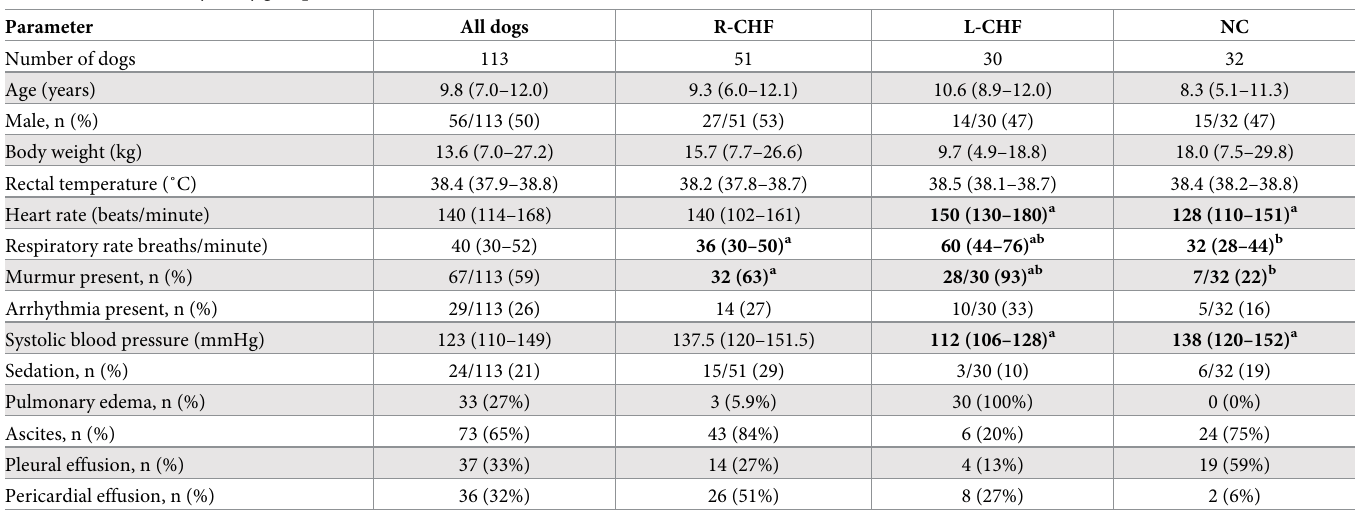
Table 1. Clinical data by study